Question: What does this figure show? Answer in one sentence.
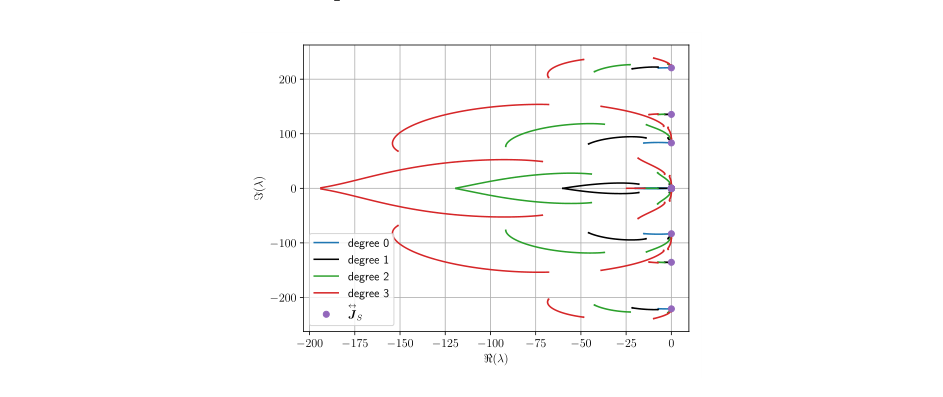
Answer: shows the eigencurves which specify the eigenvalues of ↔ D as a parametric function of kh for the above specified conditions.